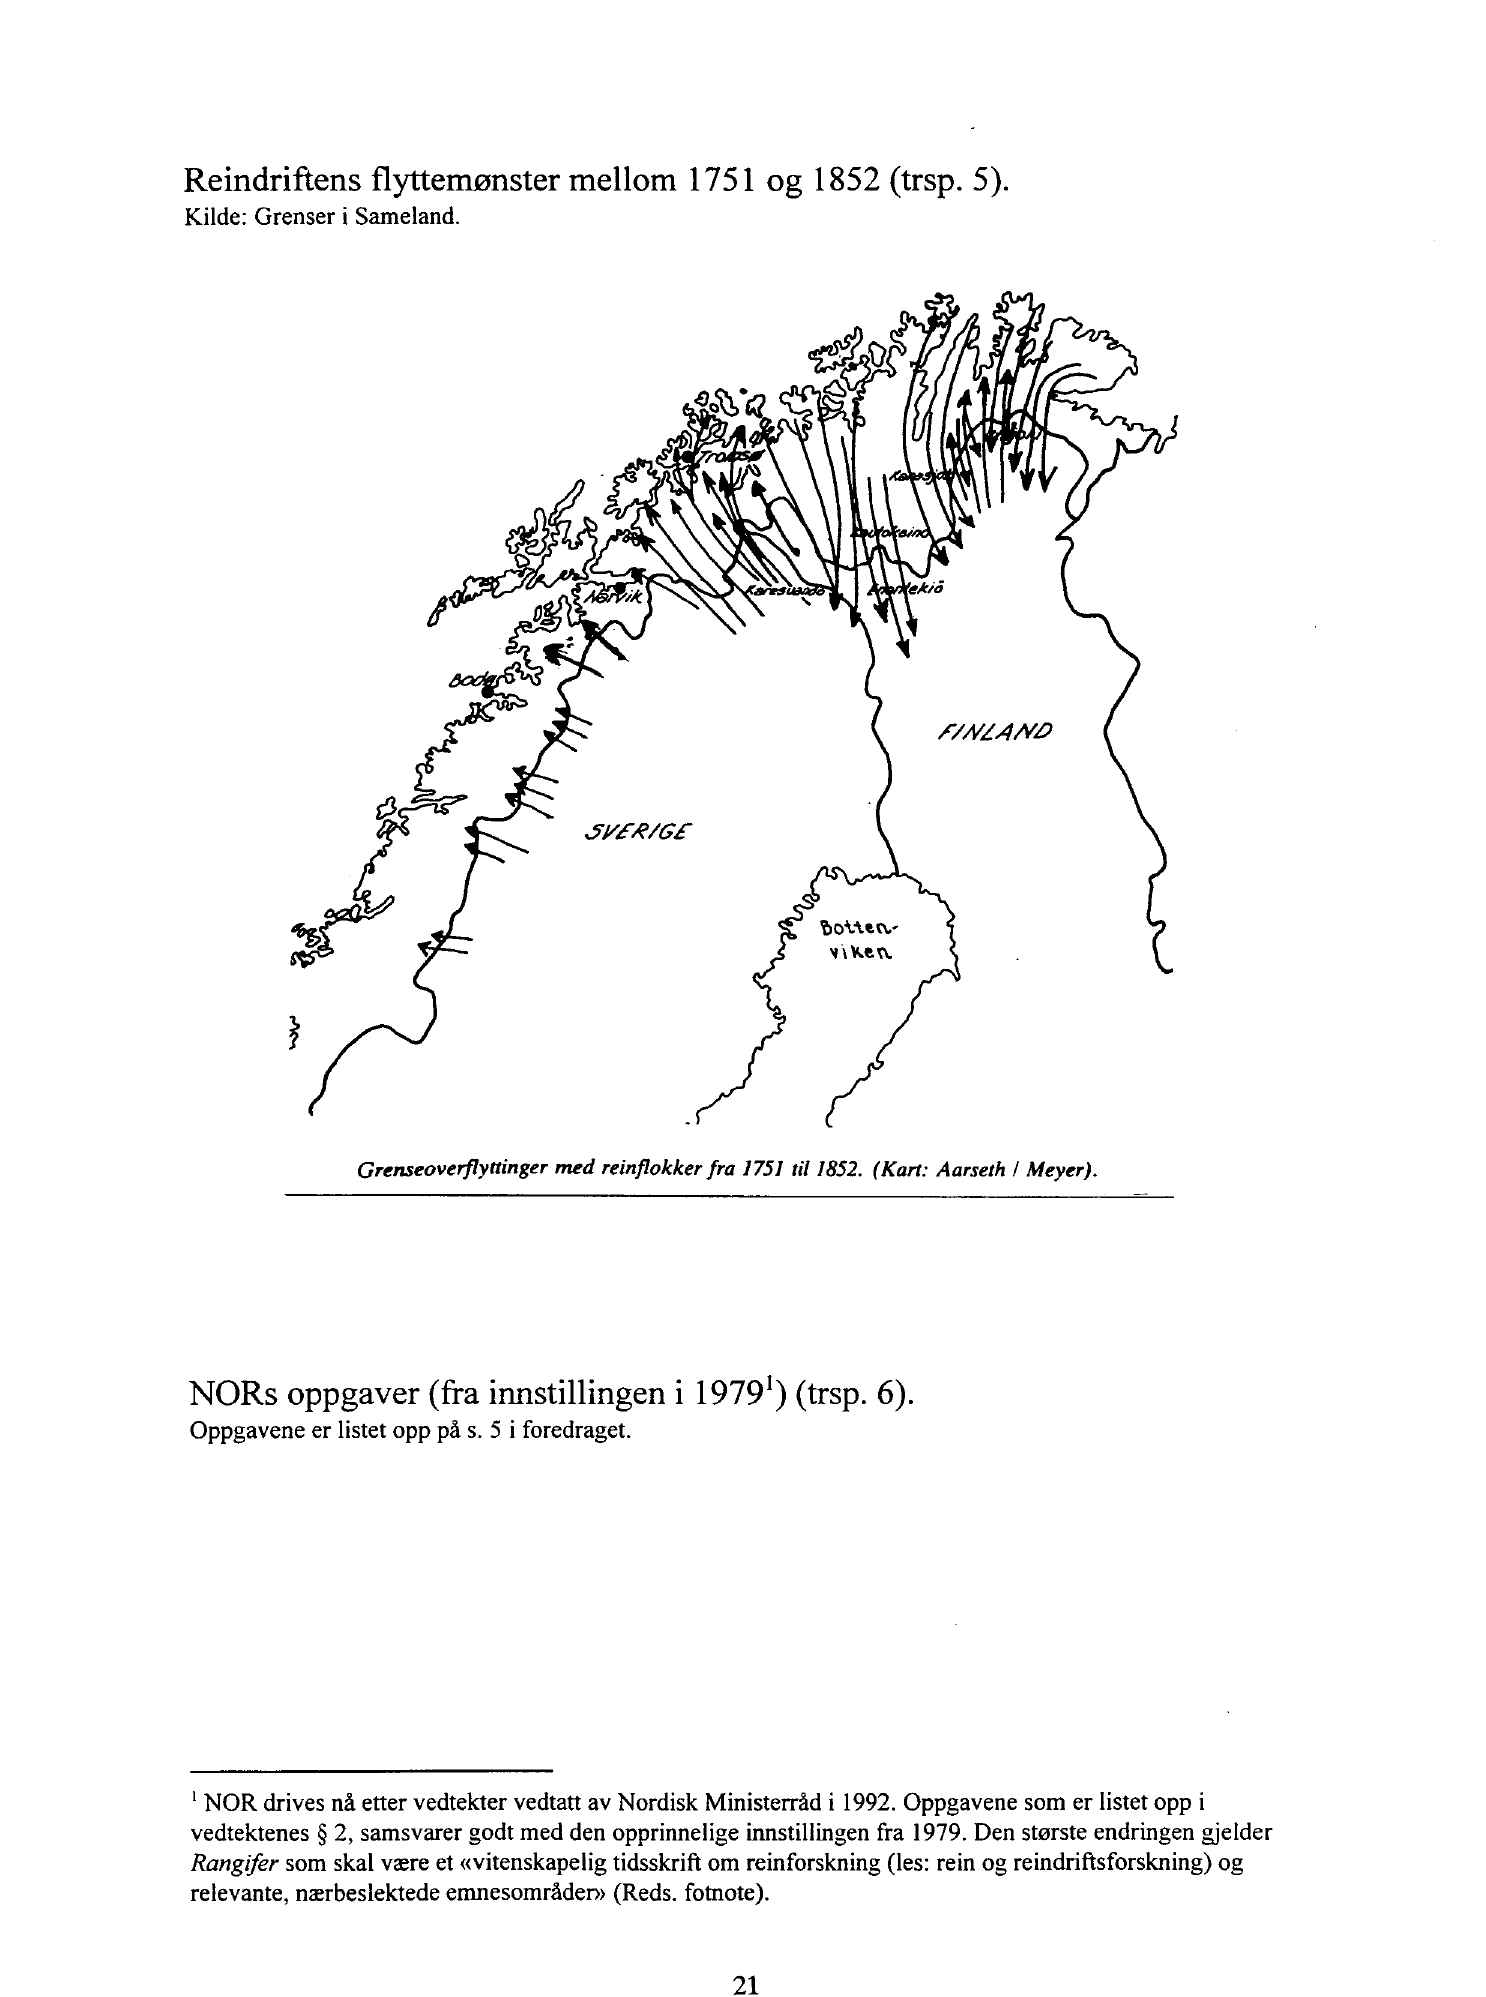
Reindriftens flyttemønster mellom 1751 og 1852 (trsp. 5). Kilde: Grenser i